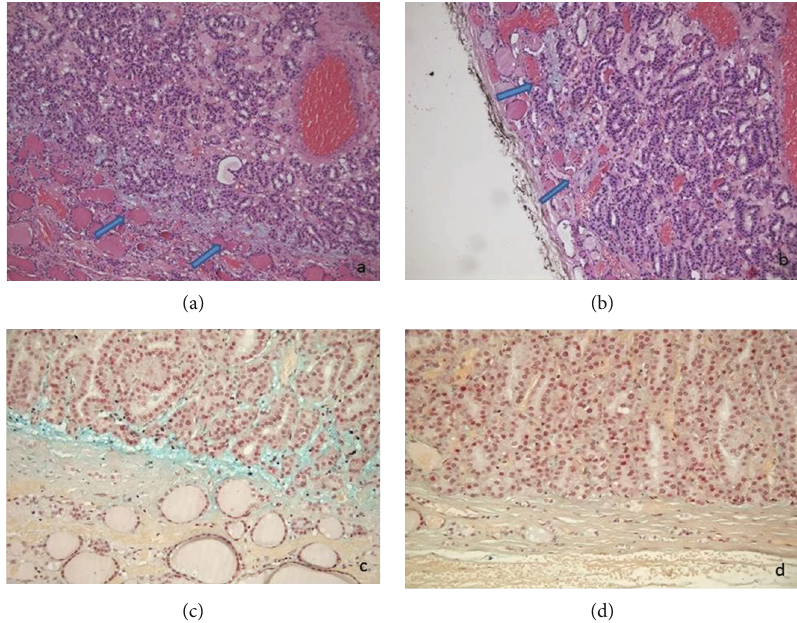
Figure 2: Stromal mucinous material (a, b) positive for Alcian Blue staining (c) at the interface between the tumor and the surrounding parenchyma, in areas in which the capsule was absent (arrows). Stromal mucinous material was absent where the capsule was intact (d). (a, b) H-E staining, 200x. (c, d) Alcian blue staining,